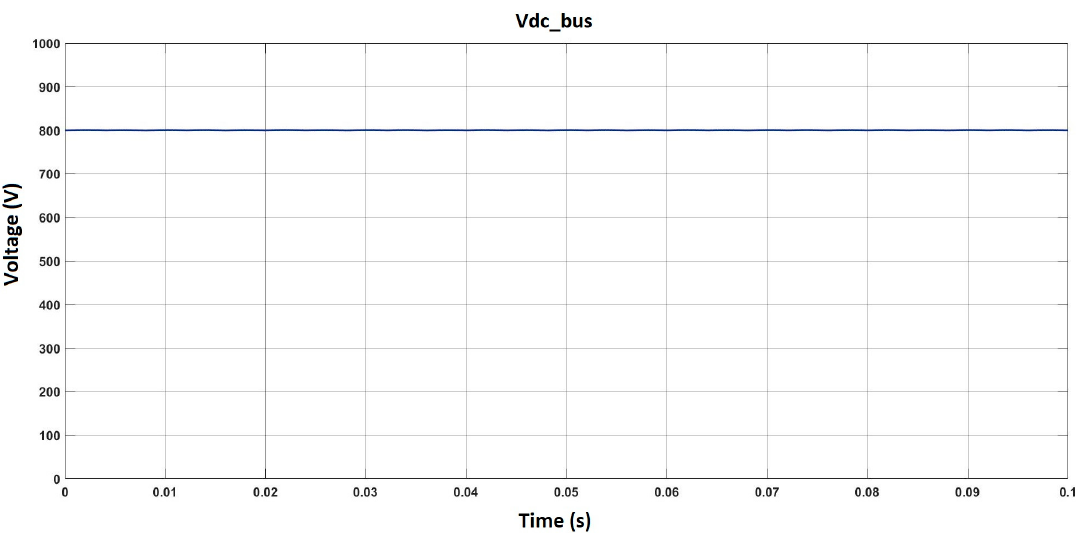
Figure 11. The common DC bus voltage for no wind